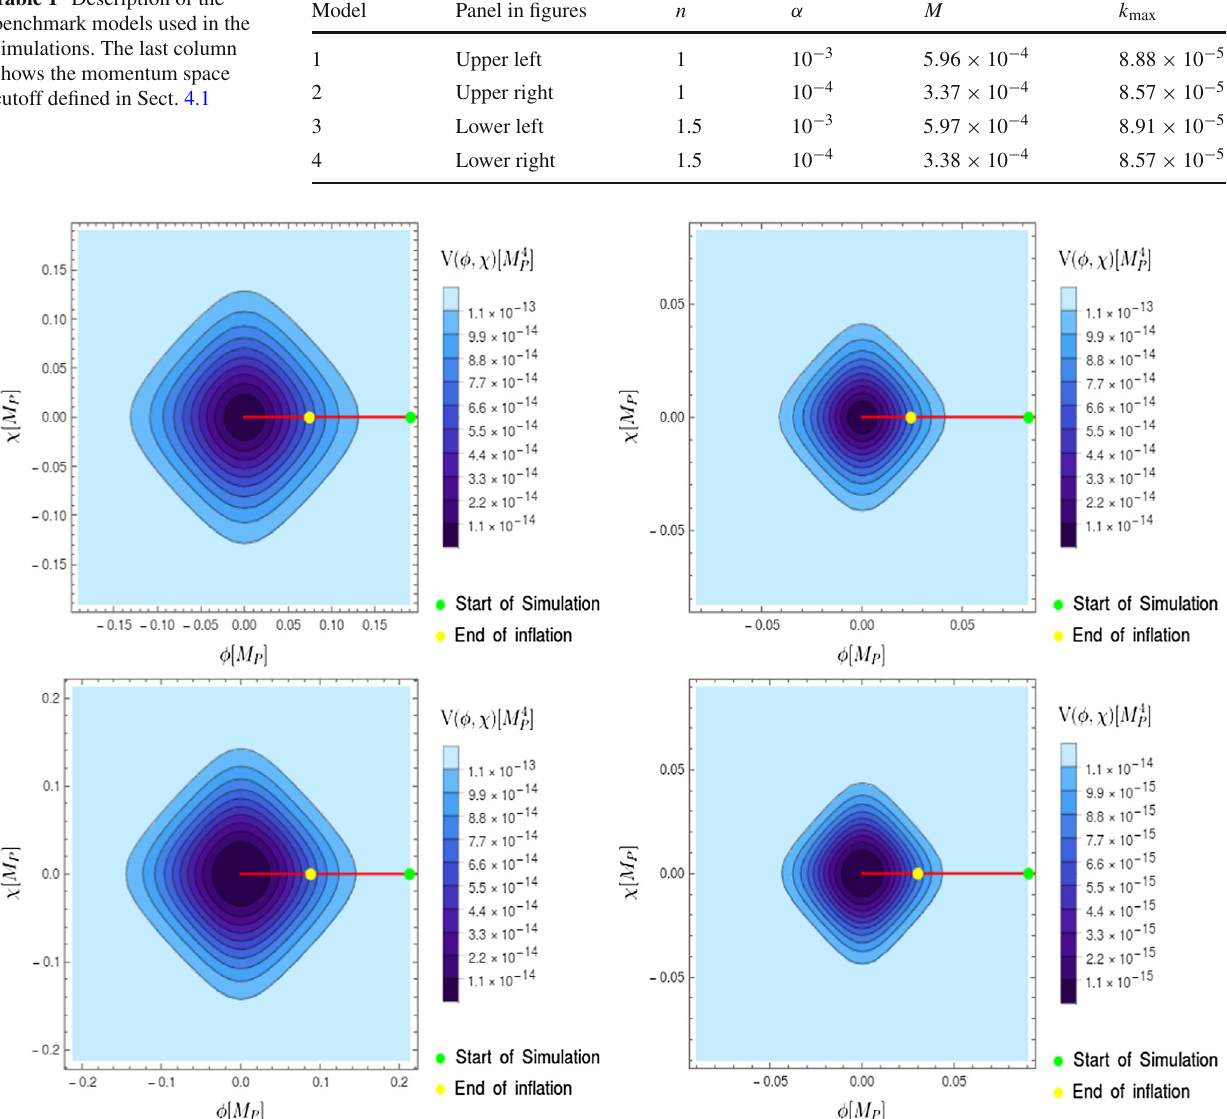
Fig. 1 Contourplotsofthetwo-fieldpotential(5)for n = 1 , α = 10 − 3 (upper left), n = 1 , α = 10 − 4 (upper right), n = 1 . 5 , α = 10 − 3 (lower left), n = 1 . 5 , α = 10 − 4 (lower right). The red line represents the infla-